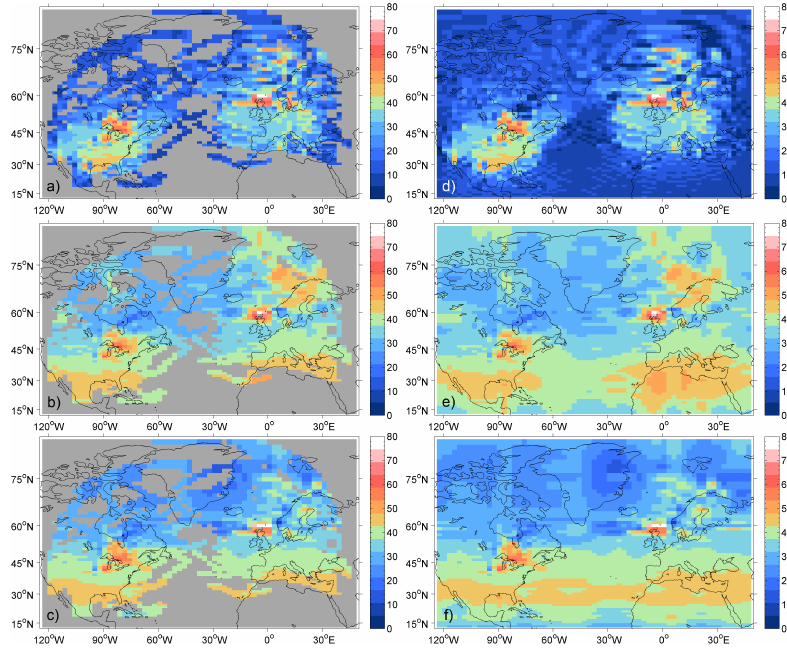
Figure 5. Reconstructions obtained at high resolution with masked out VTEC values where there is no ray coverage for (a) spherical harmonics; (b) discrete Meyer; (c) Daubechies 4; and without the mask for (d) spherical harmonics; (e) discrete Meyer; (f) Daubechies 4. Values are in TECU (10 16 electronsperm − 2